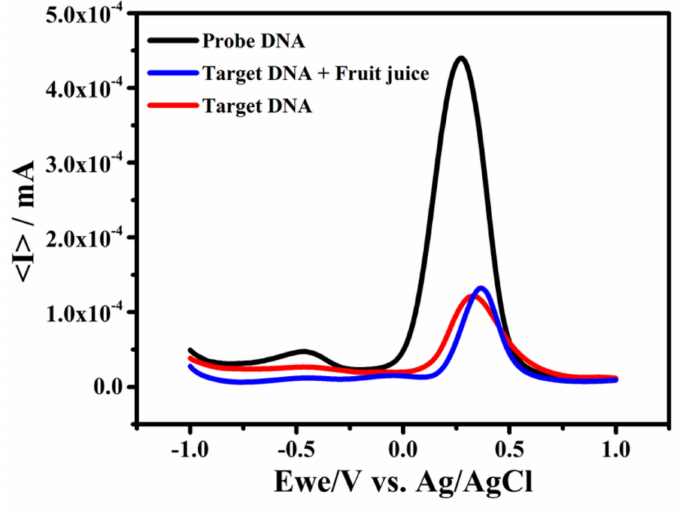
Figure 7. Differential pulse voltammogram of target DNA in real sample. All experiments